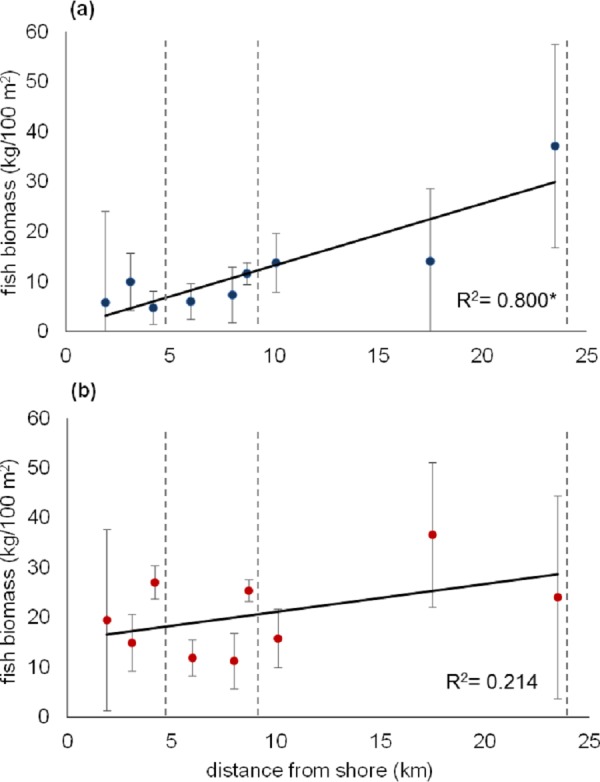
Scatter plot of mean fish biomass at 10 m and 2 m depth against distance from shore.Mean fish biomass in kg/100 m2 at (A) 10 m and (B) 2 m plotted against nearest straight line distance from shore as calculated in ArcMap. Error bars represent standard error. R2 values are shown on each panel and suggest strong correlation at 10 m and poor correlation at 2 m; (*) indicates significant regression (p = 0.009). Dotted vertical lines delimit inshore, midshelf, and offshore areas. Fish surveys were conducted in May 2013 on nine reefs in the central Saudi Arabian Red Sea, with 3 replicate 25 × 8 m belt transects at each depth per reef.